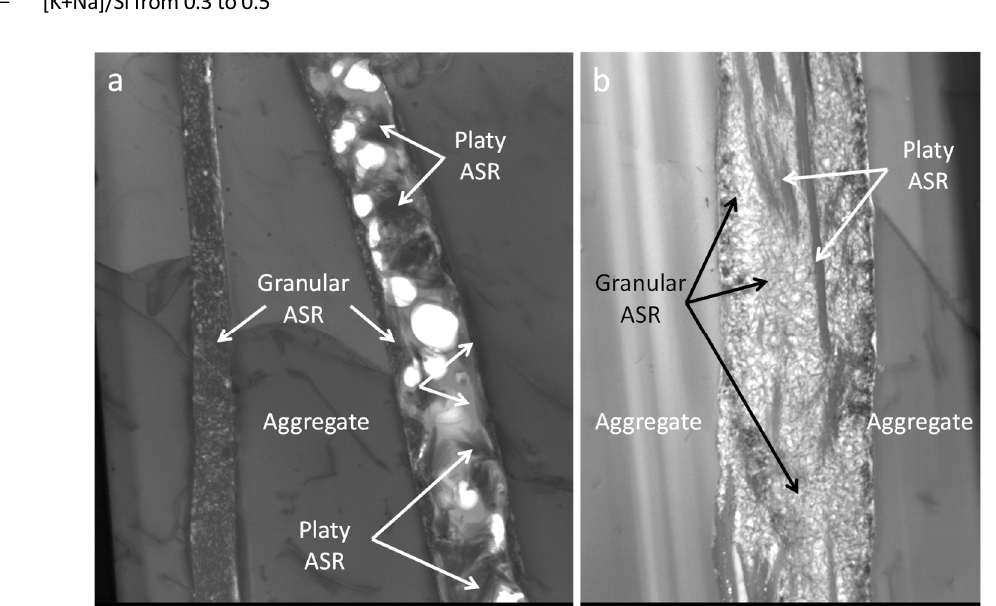
Figure 4. (a) ASR granular and platy product filling cracks in SiO 2 mineral phase after 4 weeks in accelerated conditions and (b) collected in field